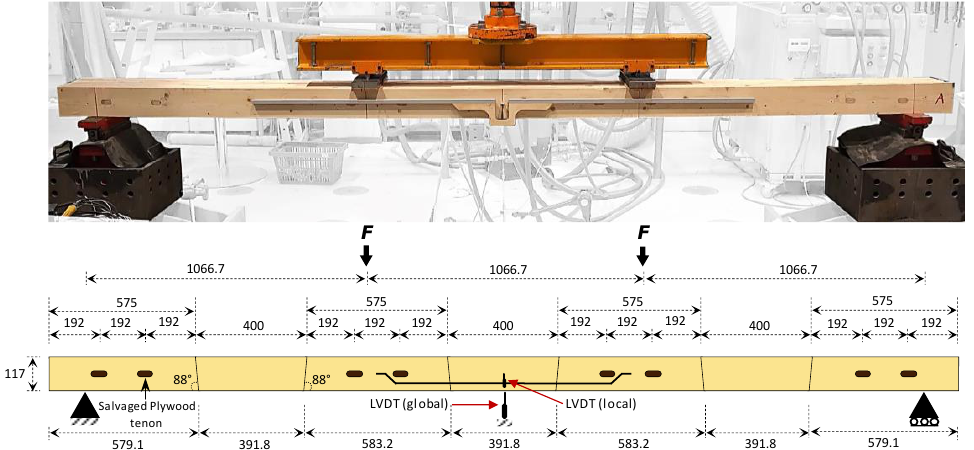
Figure 3. The dimensions of the salvaged timber elements in the large-scale DLT panels and the four-point bending test set-up. Dimensions in mm.